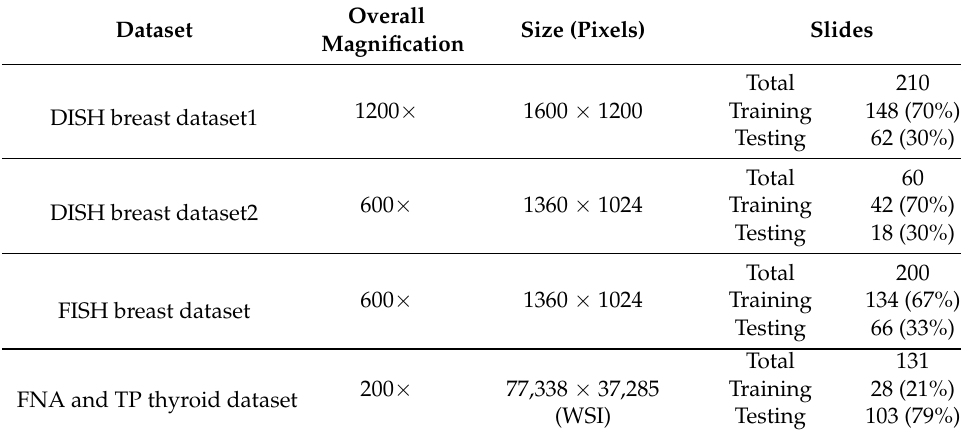
Table 1. Detailed information of experimental